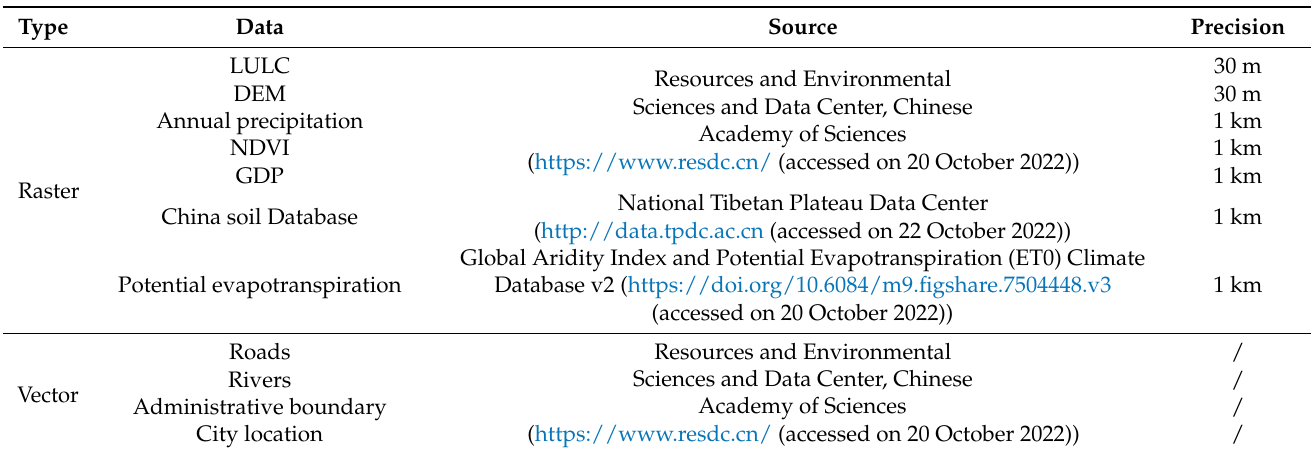
Table 1. Data sources for this study.